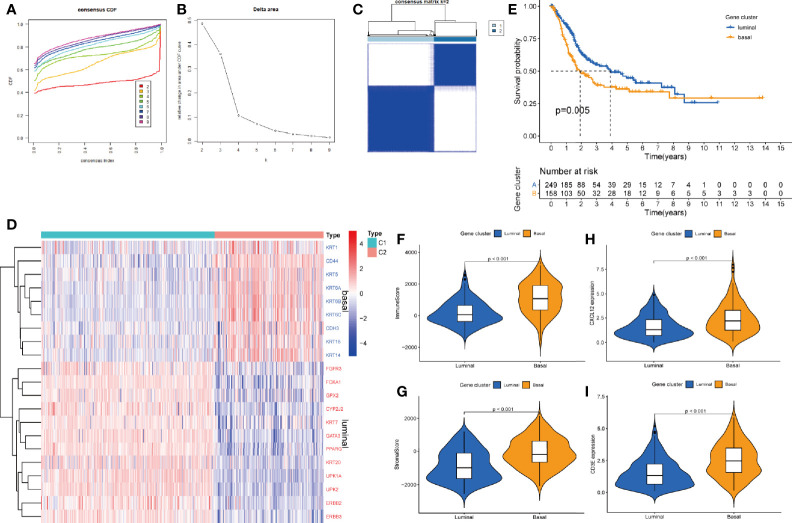
The correlations between hub genes and molecular subtypes. (A) Consensus clustering cumulative distribution function (CDF) for k = 2–9. (B) Relative change in area under CDF curve for k = 2–9. (C) Consensus matrix plot when k = 2. (D) Heatmap of luminal and basal marker genes within subtypes. (E) K-M analysis for OS of BLCA patients based on different subtypes. The different immune (F) and stromal score (G) in basal and luminal subtype. The different level of CXCX12 (H) and CD3E (I) in basal and luminal subtype.